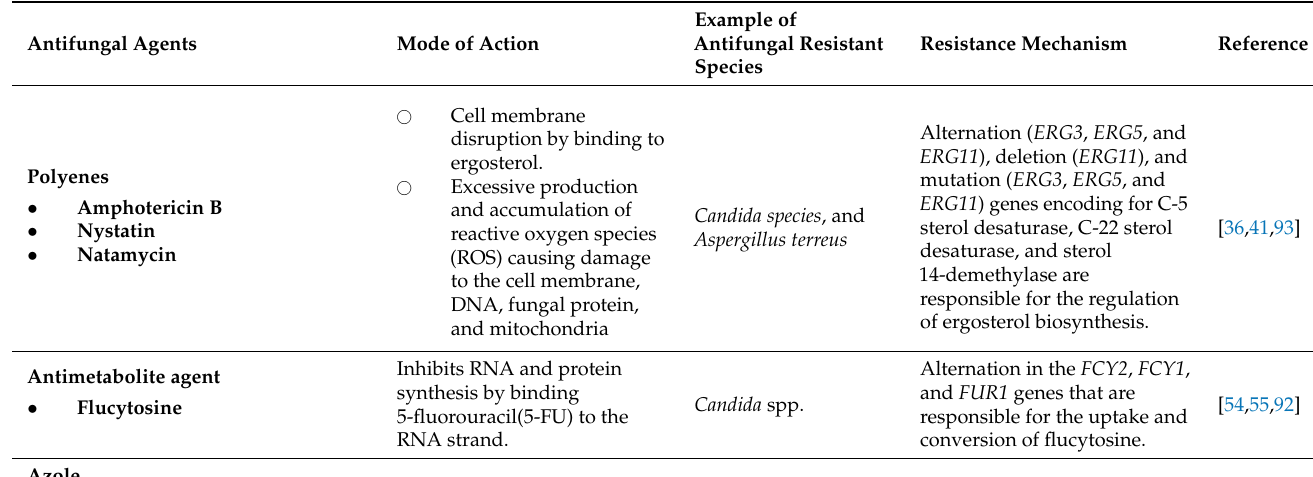
Table 1. List of all four groups of antifungal agents and their resistance